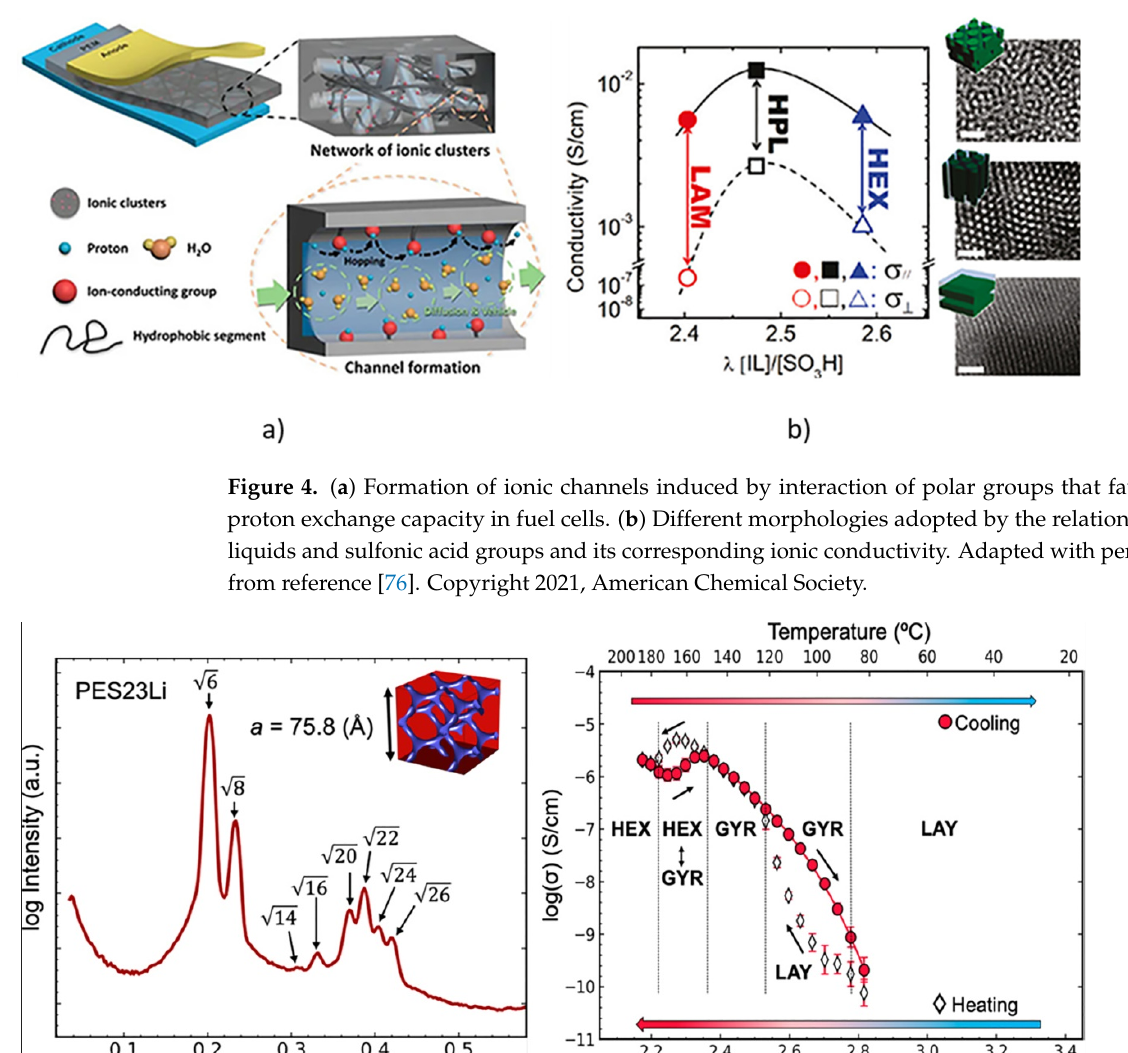
Figure 5. Small-angle X-ray scattering profile (SAXS) of polyethylene sulfonated at 150 °C exhibits the Ia3d cubical gyroid phase having a Li + as counterion. And evaluation of the its ionic conductivities upon cooling from 190 to 25 °C, ∼ 1 °C/min followed by a second heating of 25 to 190 °C, ∼ 1 °C/min. Adapted with permission from reference [144]. Copyright 2021, American Chemical Society.